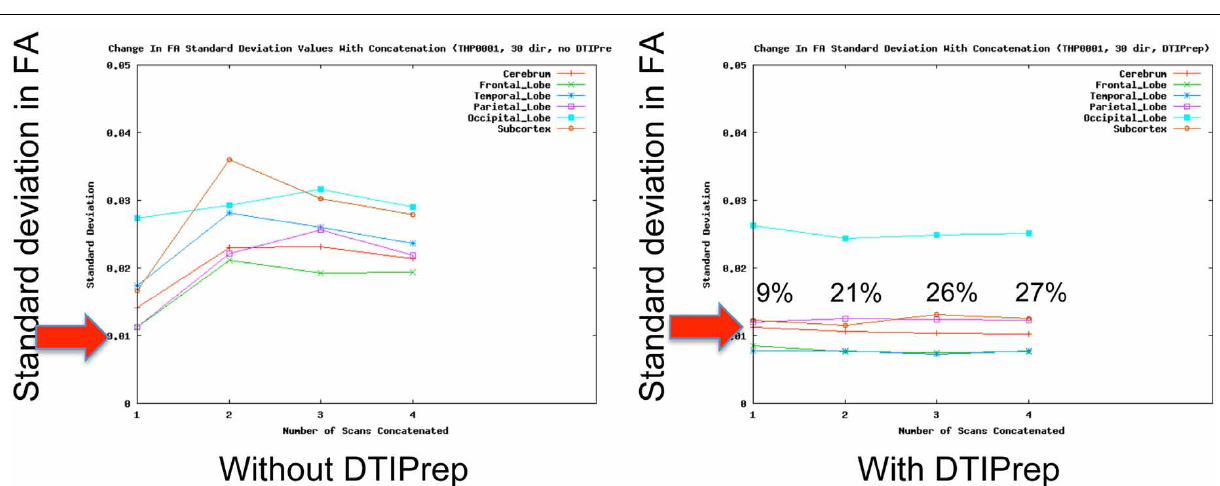
when the number of included repeat scans (horizontal axis) is increased. Percentage figures indicate number of gradient directions excluded by DTIPrep. Courtesy of V. Magnotta (University of